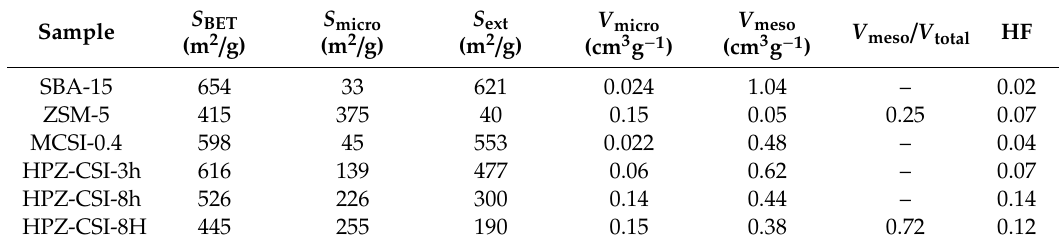
Figure 4. N 2 adsorption/desorption isotherms and the corresponding pore size distributions of HPZ-CSI- x samples. Table 1. Structural parameters and acidity of the samples. HF: hierarchy factor.